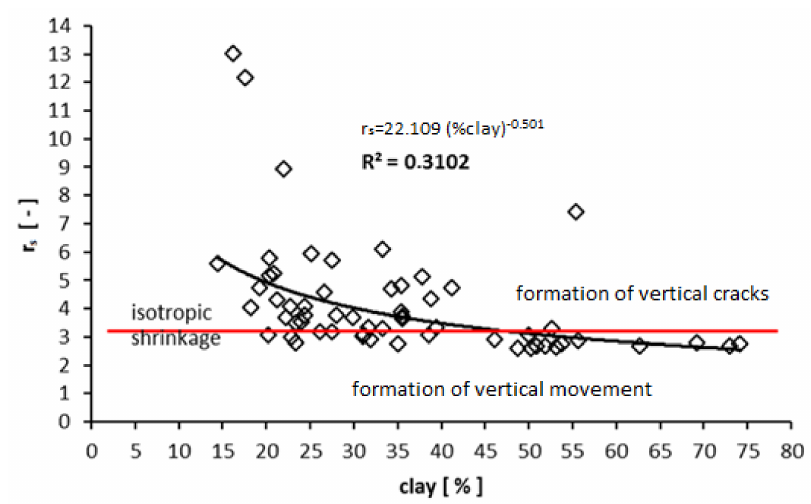
Figure 3. Relationship between the geometric factor, r s , and grain content of particles sized <0.002 mm, which represents the percentage of clay particles in soil samples.